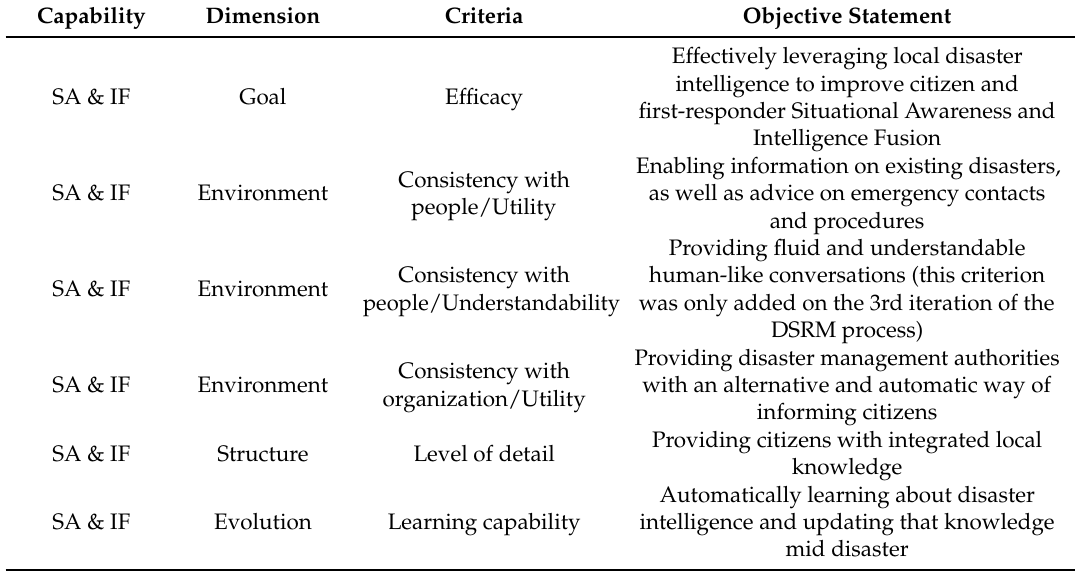
Table 4. Objective statements to be used in the DSRM evaluation.